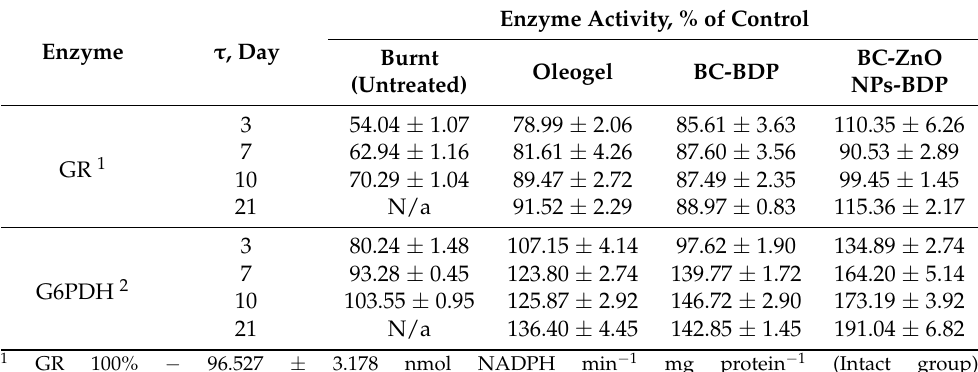
Table 7. The activity of glutathione reductase and glucose-6-phosphate dehydrogenase under the action of the studied drugs (% of control), n = 3, p <0.001. Enzyme Activity, % of Control Enzyme τ , Day BC-ZnO Burnt Oleogel BC-BDP (Untreated)